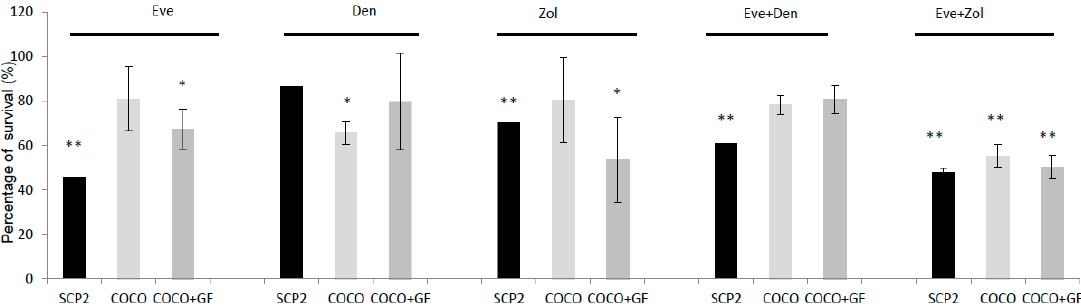
Figure A1. Drug effect on SCP2 directly co-cultured with osteoclasts; significance related to the corresponding untreated sample: * p < 0.05 and ** p < 0.001.